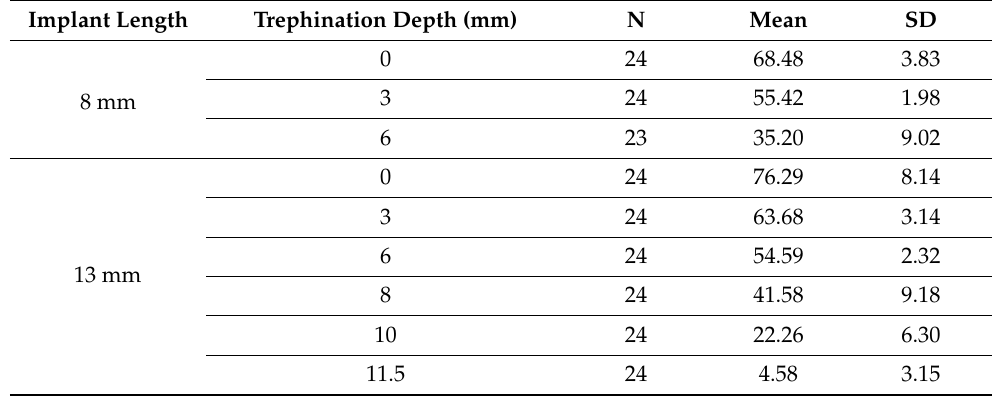
Table 1. The mean ISQ values and trephination depths. Implant